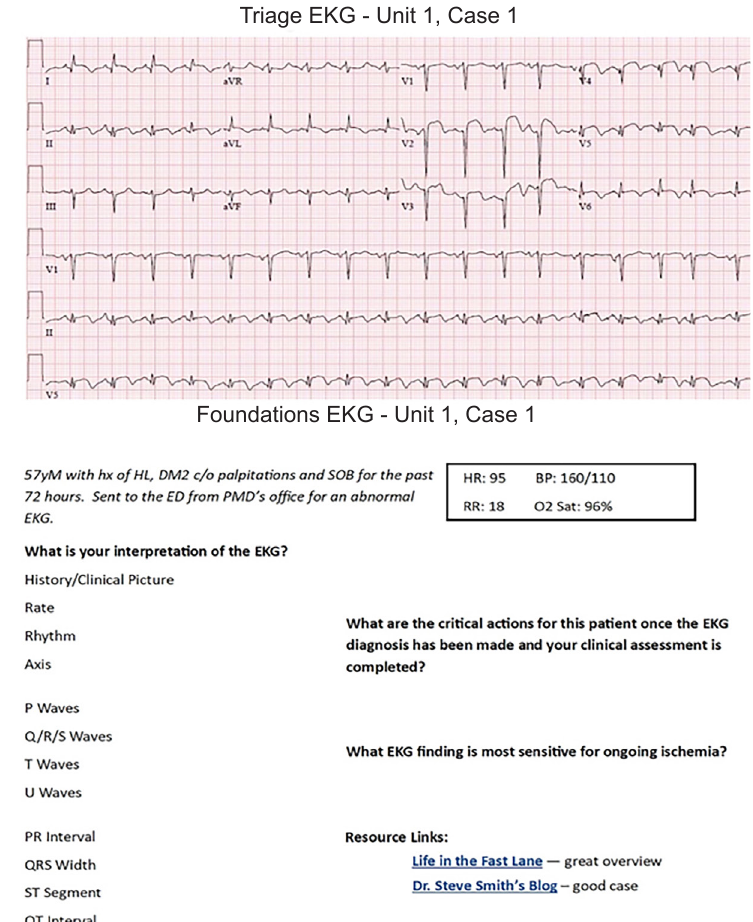
Figure 1. Challenge electrocardiogram, standardized interpretation stem, and questions. Challenge EKGs are provided to learners prior to Foundations meetings and contain the standardized interpretation and relevant questions. EKG,